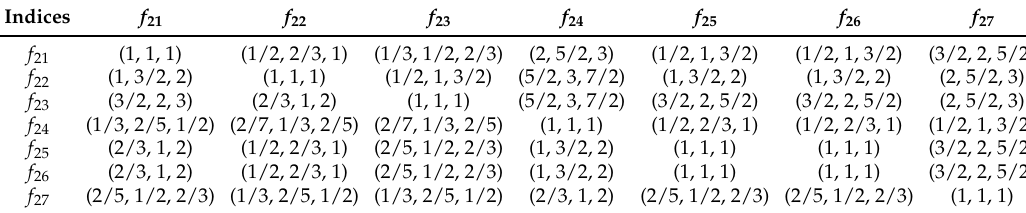
Table A2. Fuzzy comparison matrix of the indices of the oil testing